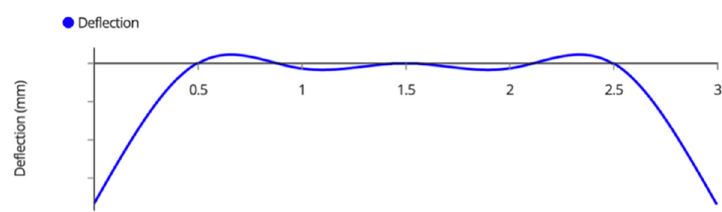
Figure A12. Beam deflection diagram.